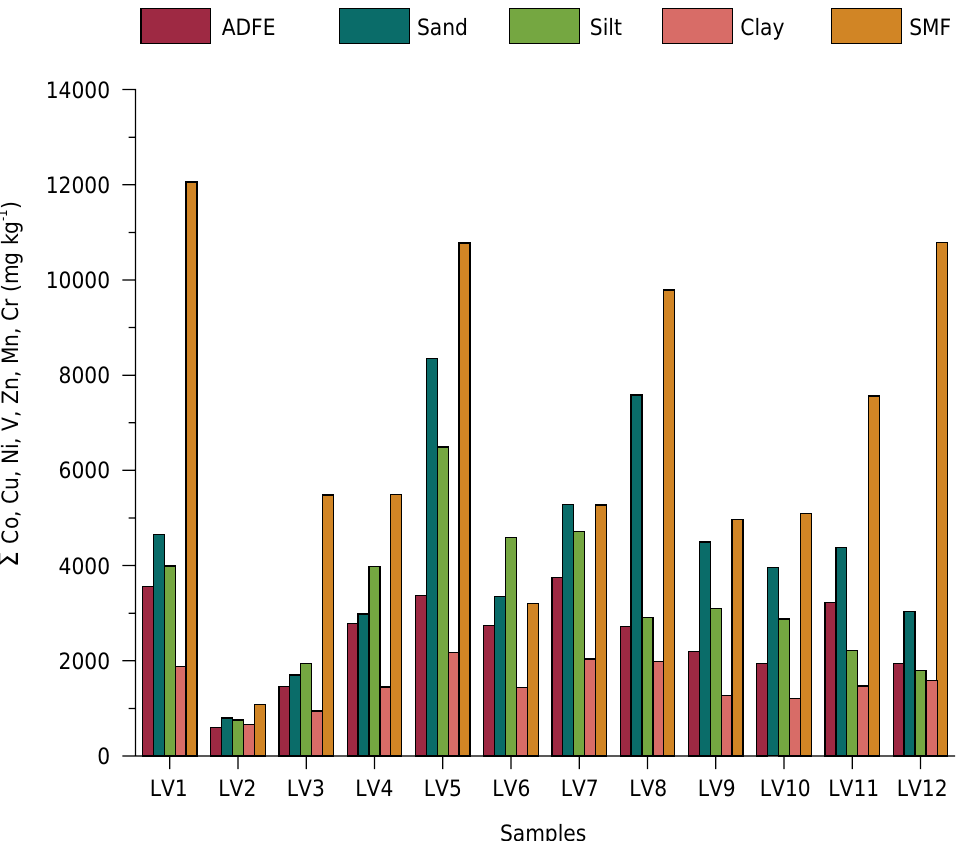
Figure 10. Total trace element contents determined for ADFE, sand, silt, clay, and sand magnetic fraction of the soils. LV 1 , LV 3 , LV 4 , LV 5 , LV 6 , LV 8 , LV 9 , LV 10 , and LV 11 : Rhodic Hapludox; LV 2 , LV 7 , and LV 12 : Rhodic